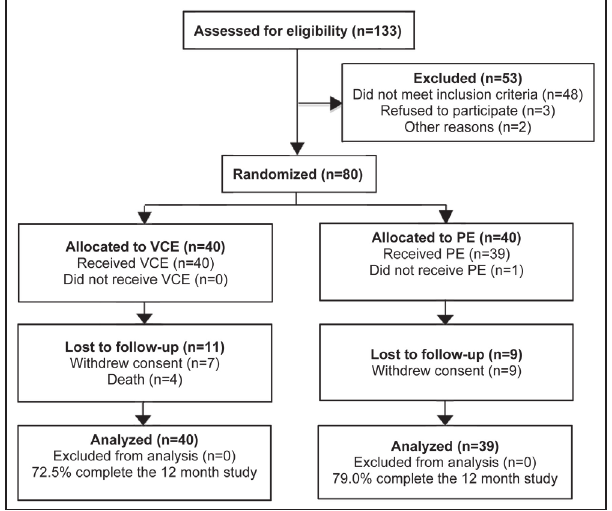
Figure 1) Study flowchart. PE Push enteroscopy; VCE Video capsule